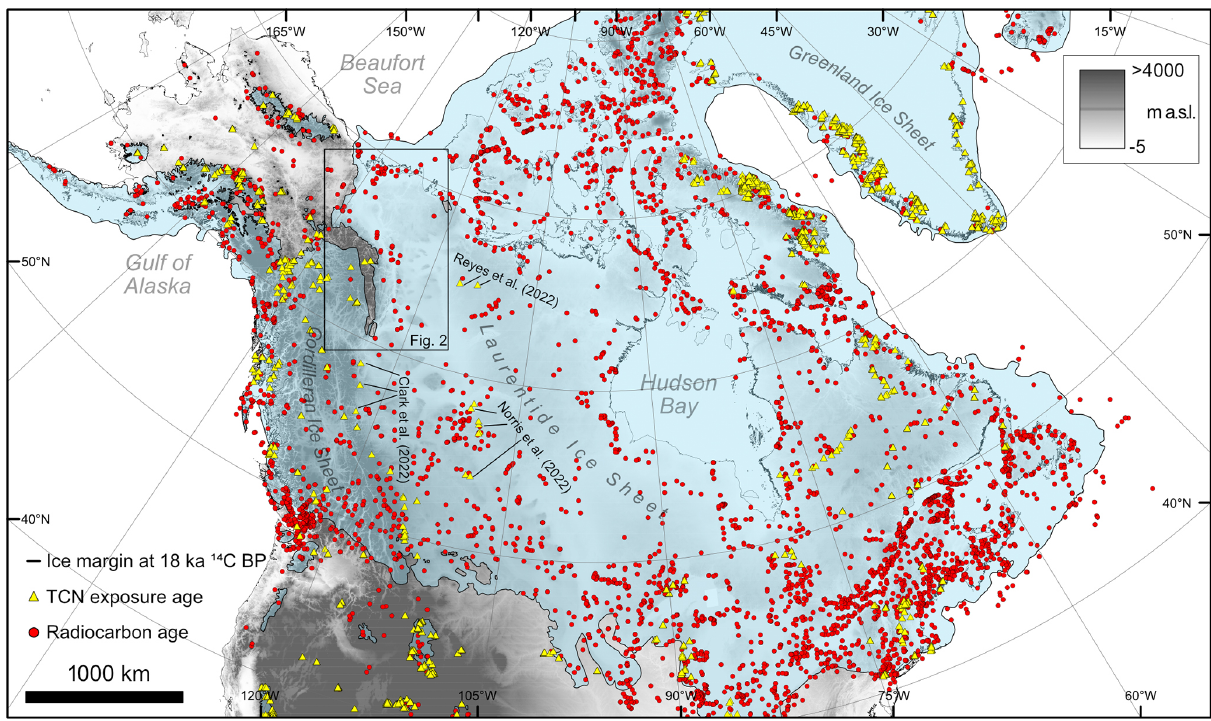
Figure 1. The Last Glacial Maximum (18.0ka 14 C/21.1kacalBP) extent of the North American Ice Sheet Complex according to the recon- struction of Dalton et al. (2020). The yellow triangles (terrestrial cosmogenic nuclide exposure ages) and red dots (radiocarbon ages) show the distribution of dates constraining deglaciation. The expage compilation by Heyman (2022) was used to plot the distribution of terrestrial cosmogenic nuclide exposure ages, and the database of Dalton et al. (2020) was used to plot the distribution of radiocarbon ages.